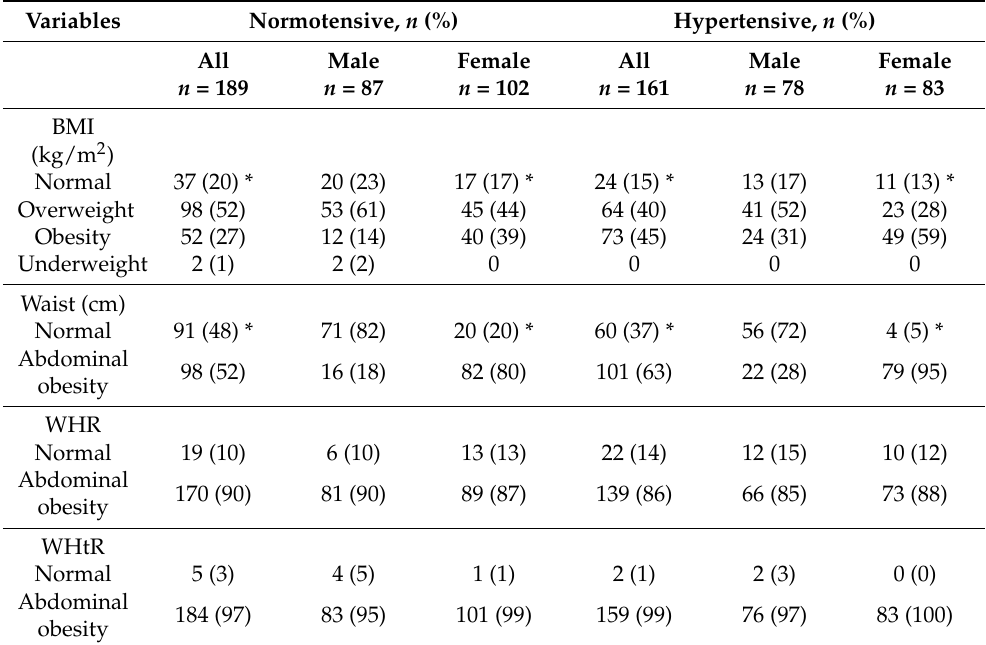
Table 3. Comparison of anthropometric indices in men and women by blood pressure